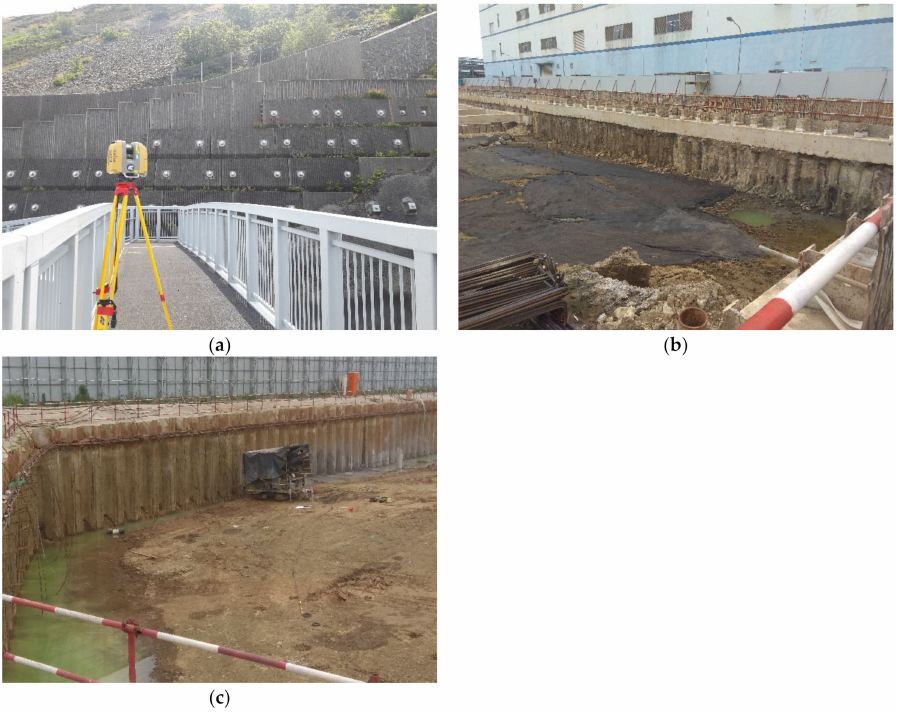
Figure 1. Laser scanning of different retaining structure types, ( a ) Concrete panel;( b ) Soil mixing wall;( c ) Sheet